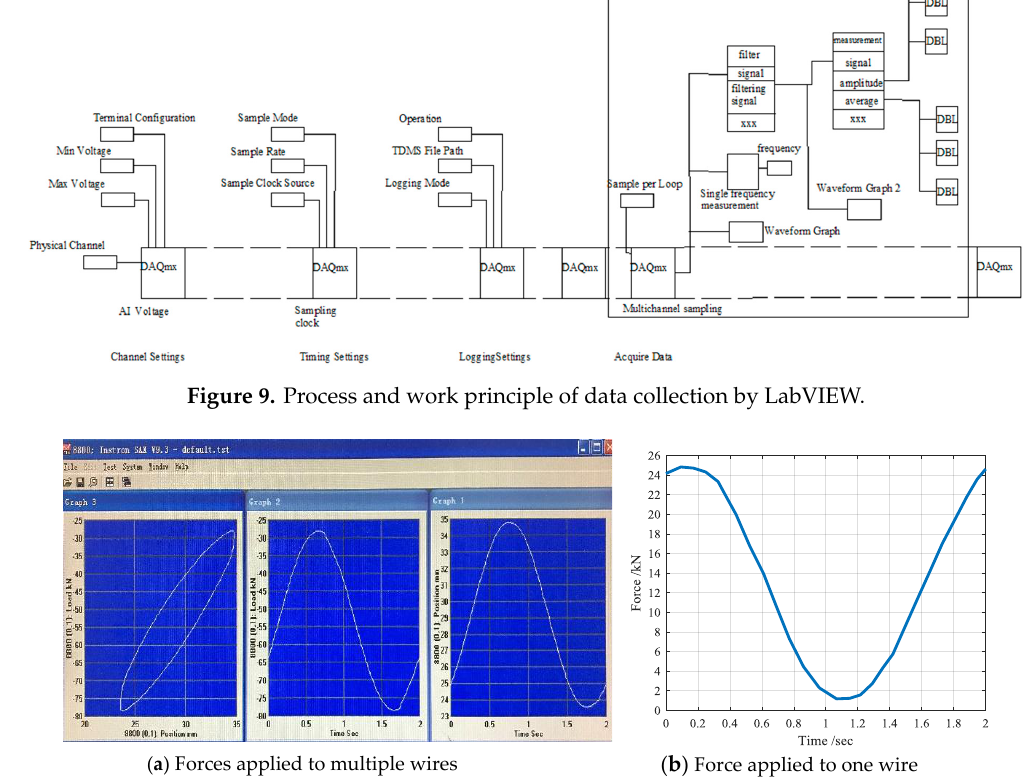
Figure 10. Display interface of fatigue loads recorded by LabVIEW.